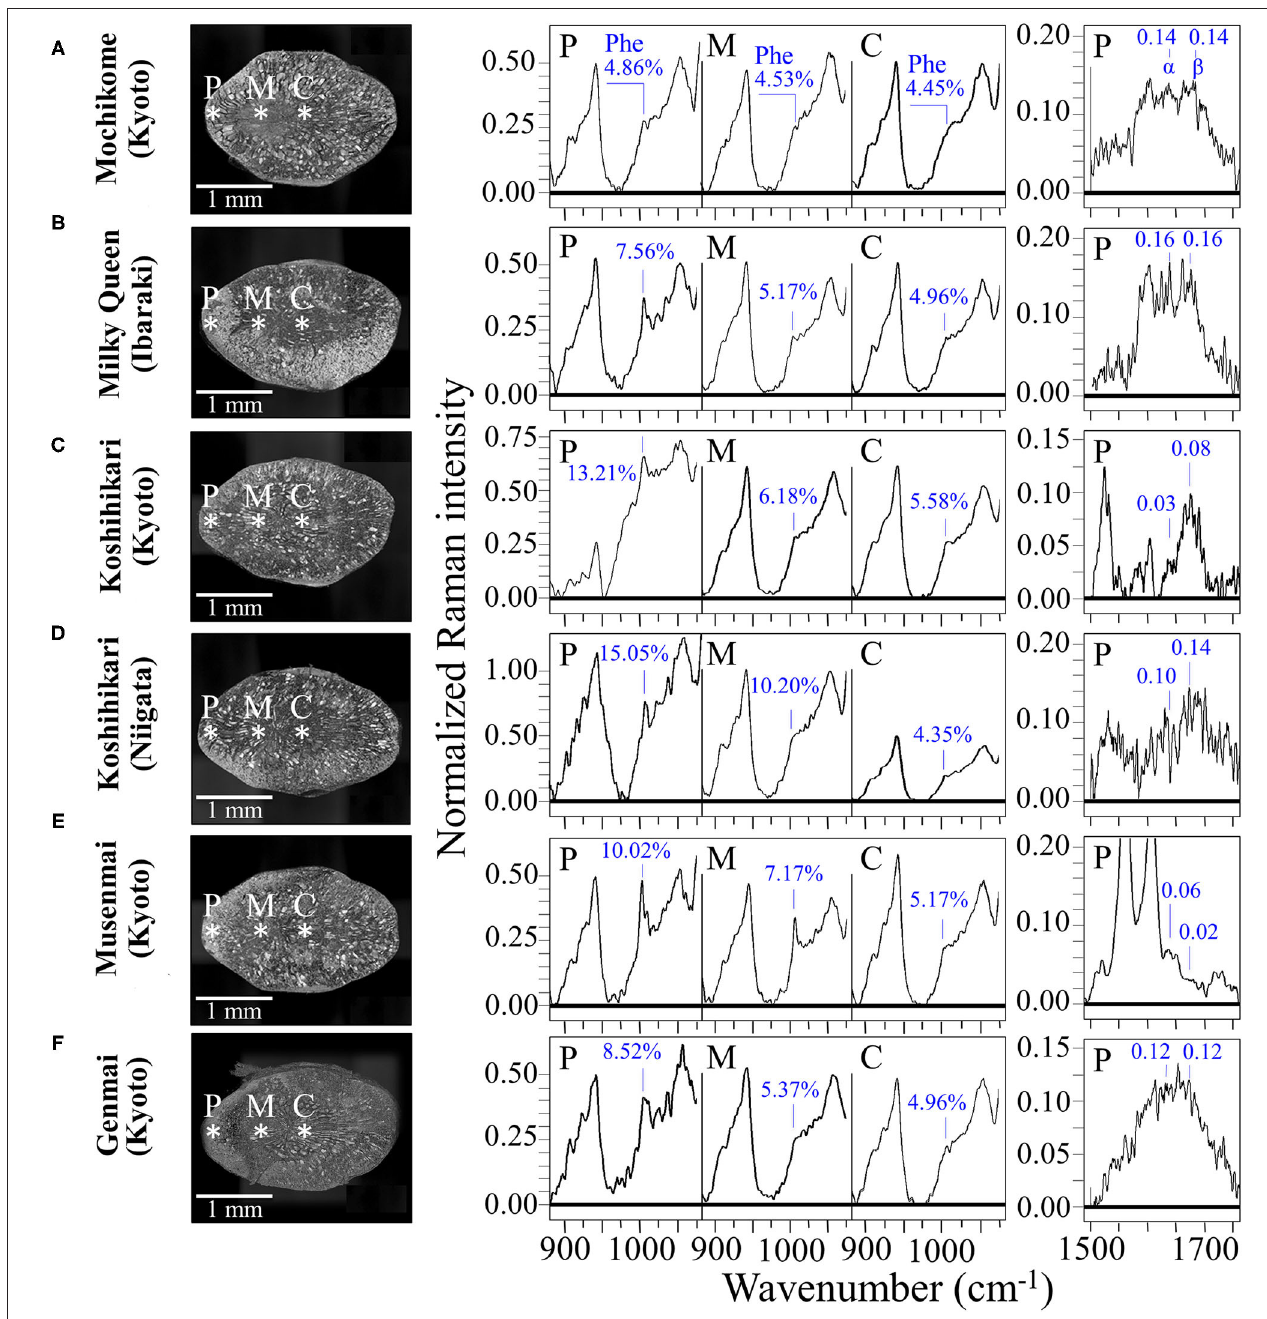
FIGURE 6 | Laser microscopy images of kernel cross sections from six different Japanese rice cultivars (A) Mochikome (Kyoto), (B) Milky Queen (Ibaraki), (C) Koshihikari (Kyoto), (D) Koshihikari (Niigata), (E) Musenmai (Kyoto), and (F) Genmai (Kyoto). Laser microscopy images of kernel cross sections from six different Japanese rice cultivar; in the middle part of the figure, the related high-resolution Raman spectra collected in the spectral region 875–1,075 cm − 1 ) at peripheral, middle, and central locations of the sectioned kernels (labeled on the cross-section images with asterisks and P, M, and C, respectively) with the respective weight fractions of phenylalanine shown in inset; on the right side of the figure, high-resolution Raman spectra in the Amide I region as collected in the frequency interval 1,500–1,700 cm − 1 at the peripheral location P of different types of rice kernels. The respective sums of the relative intensities of signals from α -helix and β -sheet (labeled as α and β , respectively), are given in inset and were used to calculate the protein-to-carbohydrate ratio, R P / C . used the ratio between the Amide III band at 1,278 cm − 1 and the carbohydrate band at 362 cm − 1 (C-C stretching). We